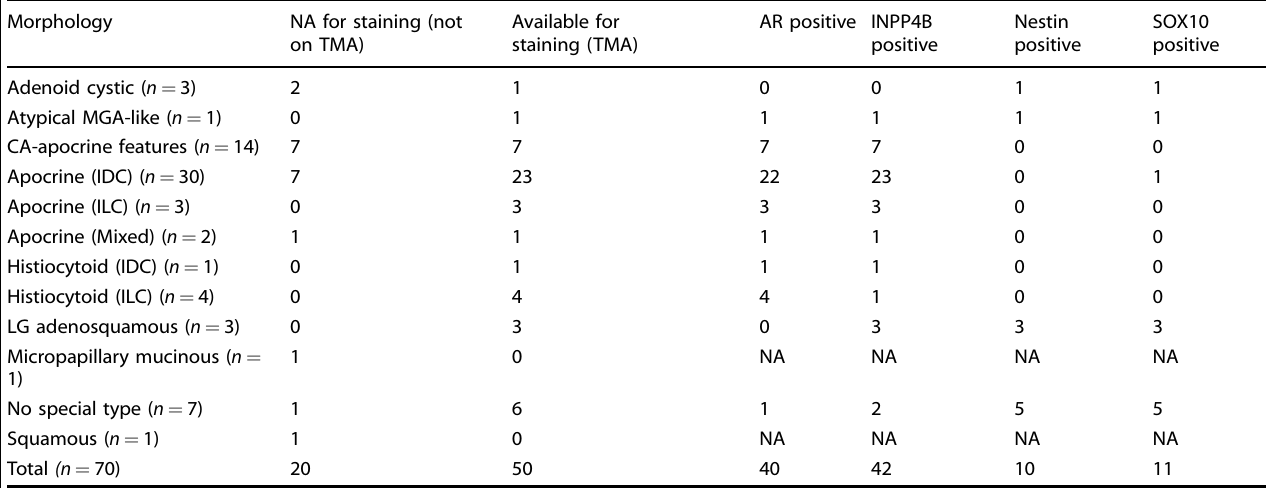
Table 4. Expression of luminal and basal markers in triple negative low proliferation (TNLP) tumors. Morphology